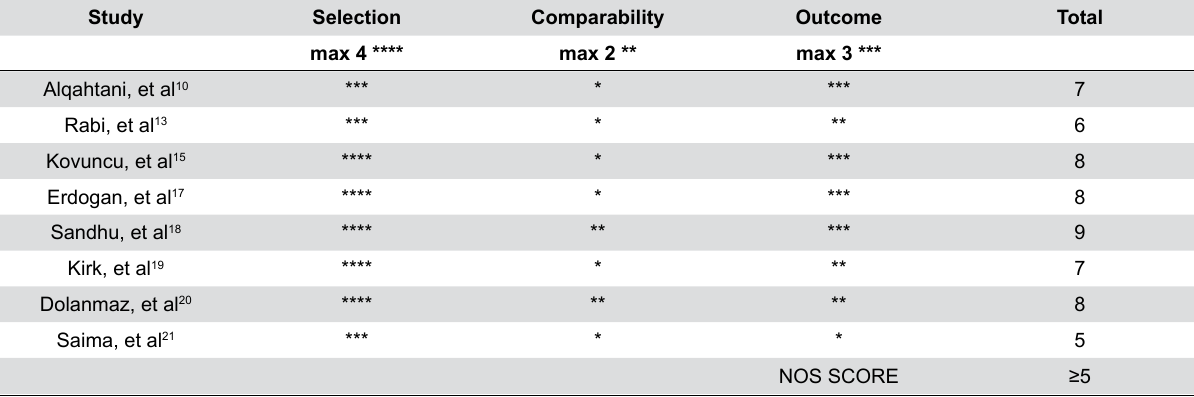
Table 3- Risk of bias and quality assessment of included nonrandomized studies using the Newcastle-Ottawa